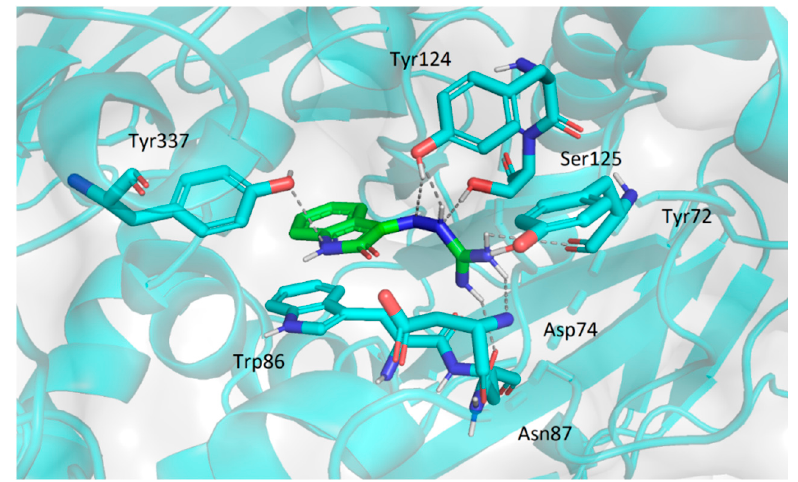
Figure 15. The binding mode of 1p (green) in AChE.